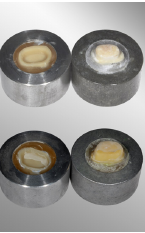
Figure 2. Observed failure types: resin composite cement remaining on dentin (pictured above) and mixed failure type (pictured below) with resin composite cement on dentine and concurrent on CAD/CAM polymer crown.